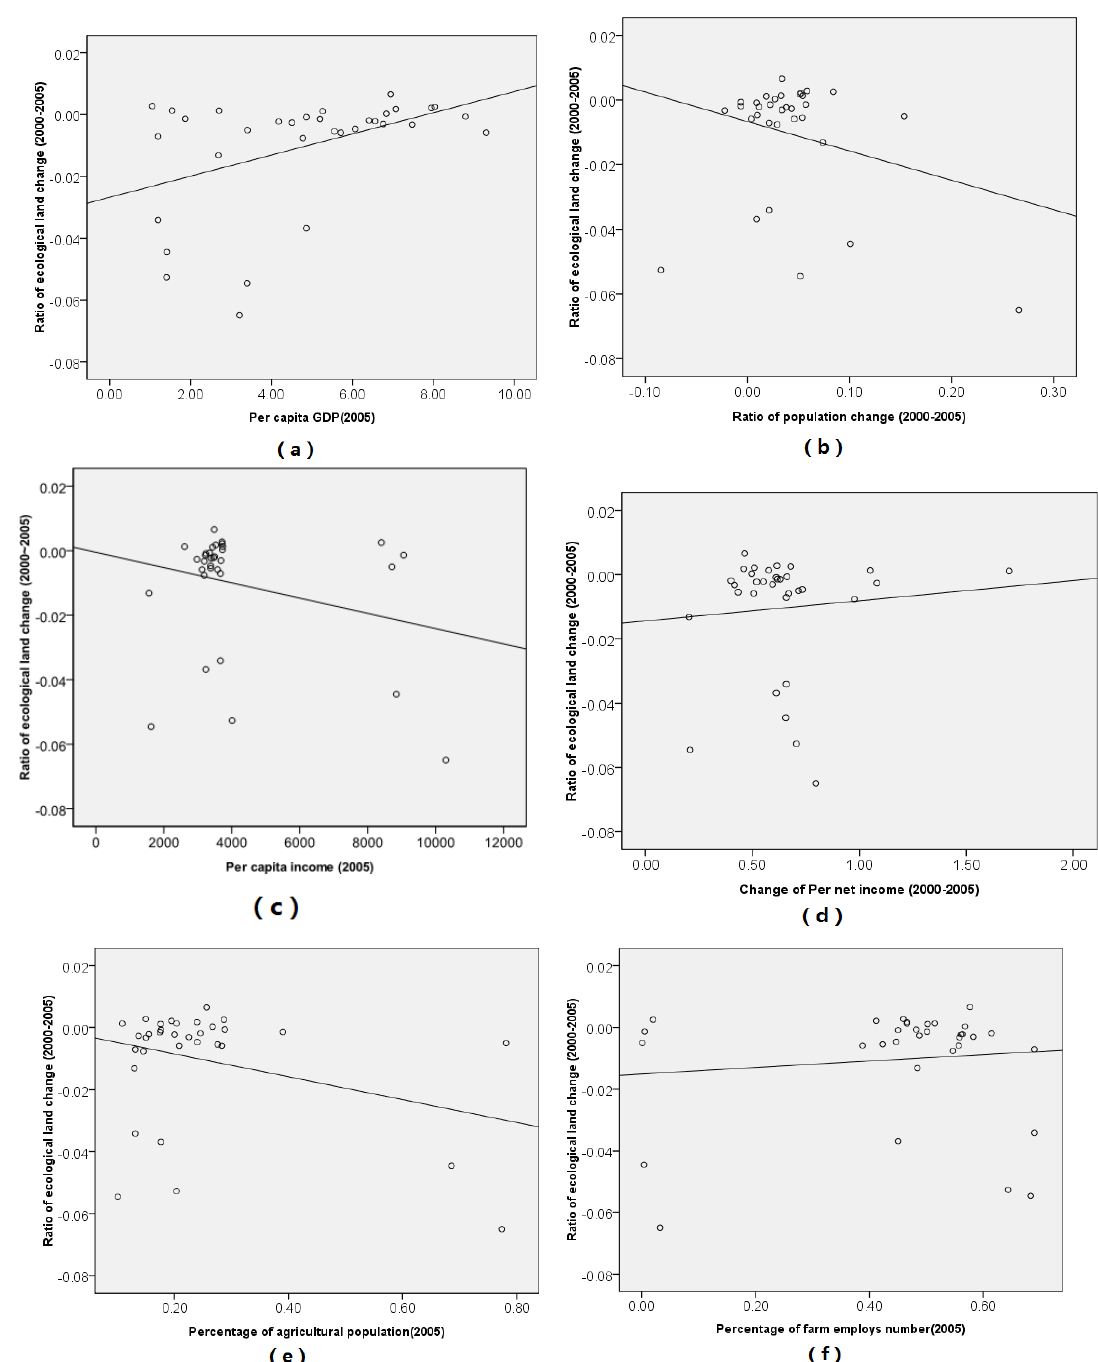
Figure 5. Scatter plot of ecological land change during 2000 to 2005 in Poyang Lake Eco-economic